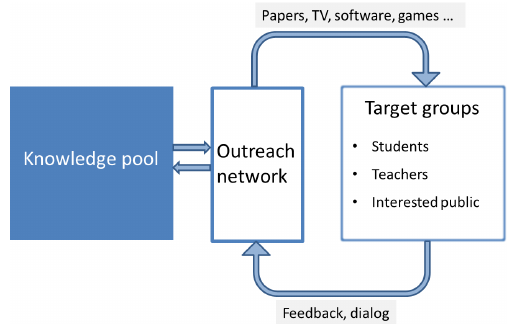
Figure 1. The “Knowledge pool” represents scientific knowledge and results that have to be transformed by a network to be un- derstandable by the target groups. In a permanent dialog with this network, students and teachers give feedback about their needs. In the PRONAS outreach network, biodiversity researchers collaborate with teachers, environmental educators, and pedagogical